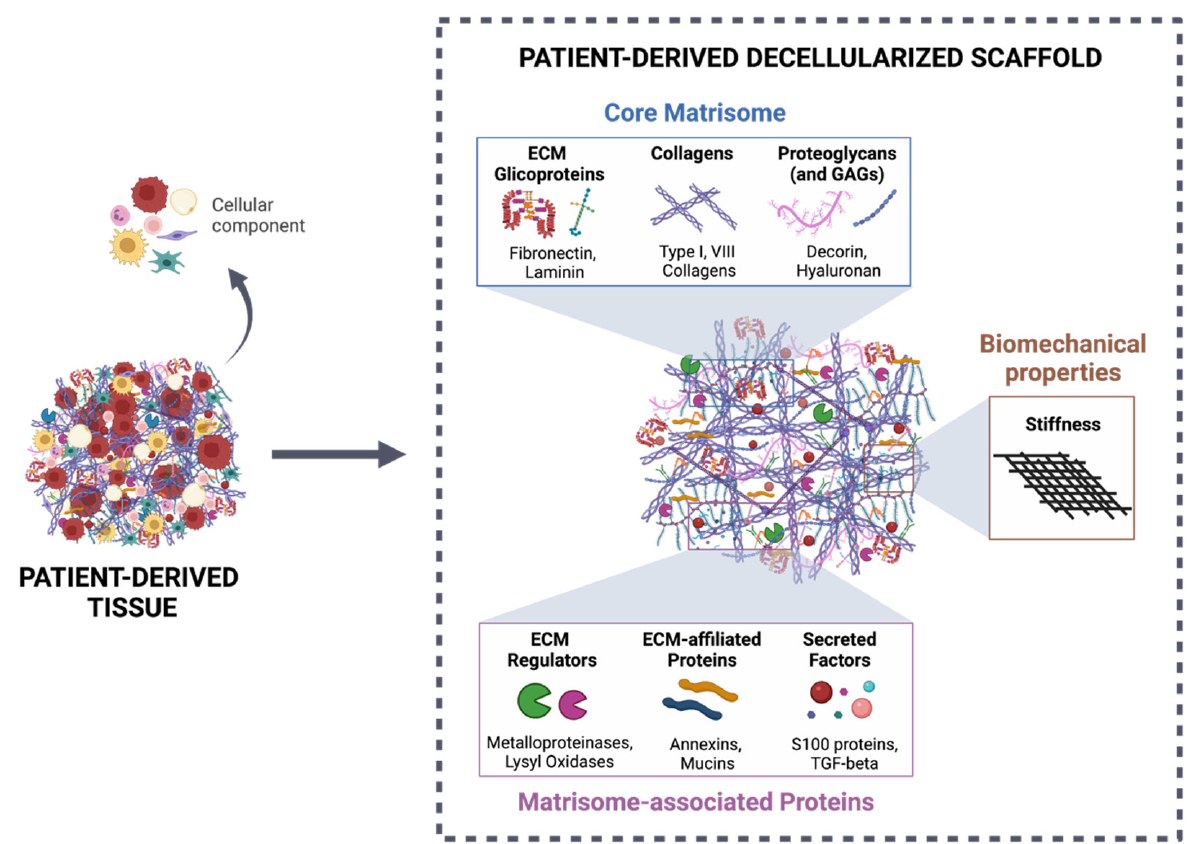
Figure 2. Patient-derived decellularized scaffold as a suitable tool for studying tumor–stroma interactions. The decellularization process of patient-derived tissue allows the efficient removal of the cellular component of the ECM, maintaining the 3D structure, as well as the biochemical categories (core matrisome and matrisome-associated proteins), according to Naba et al. [150], and biomechanical properties (stiffness). Created with BioRender.com (accessed on 10 November 2021).